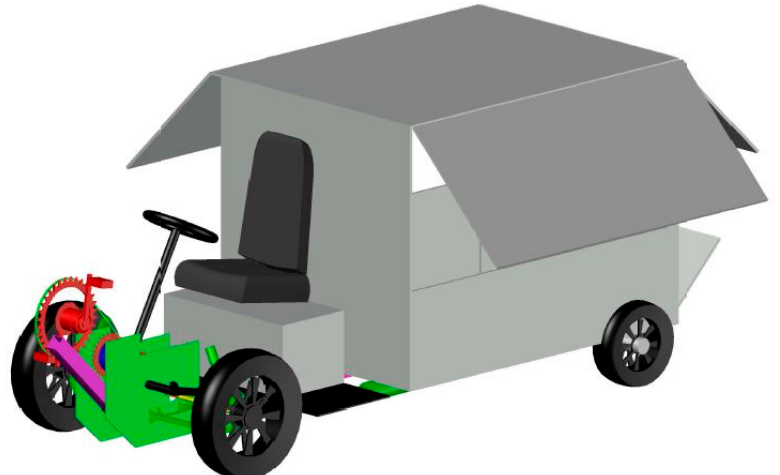
Figure 4. Modular Cargo Bike concept design.